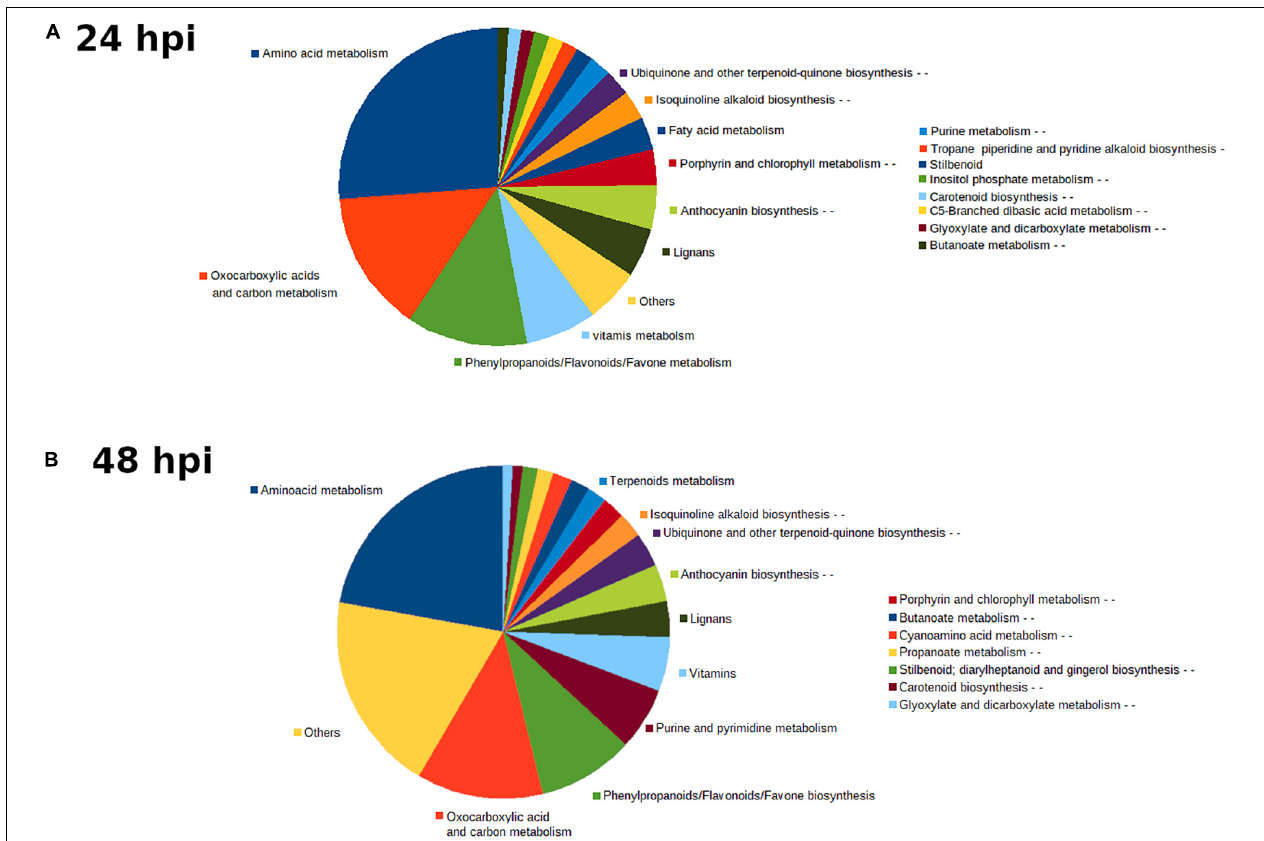
FIGURE 5 | Main pathways implicated in C. aurantium response upon T. urticae infestation. Sector graph of from mycorrhizal and non-mycorrhizal C. aurantium plants or plants previously infested with T. urticae obtained from the non-targeted metabolomic analysis by UPLC-QTOFMS. Pathways with signals more accumulated of AM inf-AM locally infested leaves compared with NM inf-NM at (A) 24 h and (B) 48 h after infestation. Four different treatments were employed: NM: non-mycorrhizal non-infested plants. AM: mycorrhizal non-infested plants. NM inf: non-mycorrhizal infested plants. AM inf: mycorrhizal infested plants. Pathways with more changes were obtained by the software MarVis (Marvis Pathway). Signals from different treatments were compared after a Kruskal–Wallis test ( P < 0.05) following adduct and isotope correction. A pool from 6 individual plants was employed for each combination. Three independent and two technical replicates were randomly performed (n =